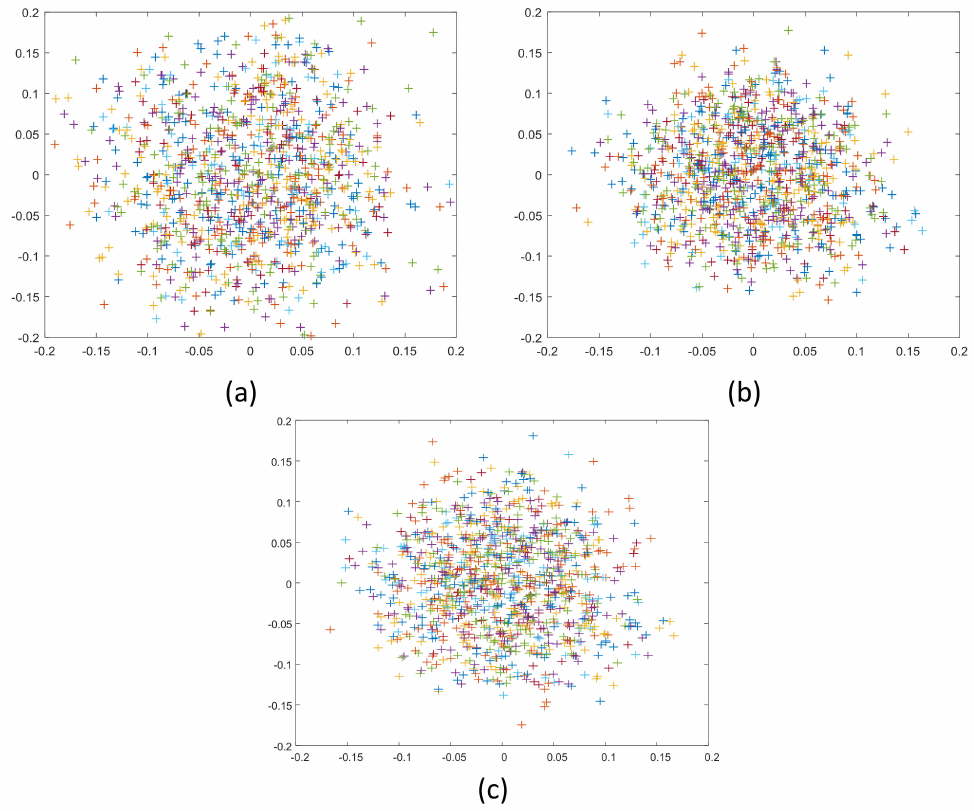
Figure 9. Re-projection error distribution for different images marked as different colors: ( a ) Zhang’s method [21]; ( b ) proposed method; ( c ) Li’s method